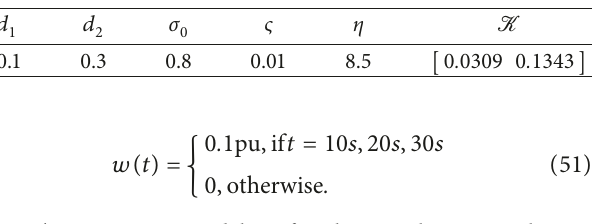
Table 6: The control gain K for fixed d Theorem 2.